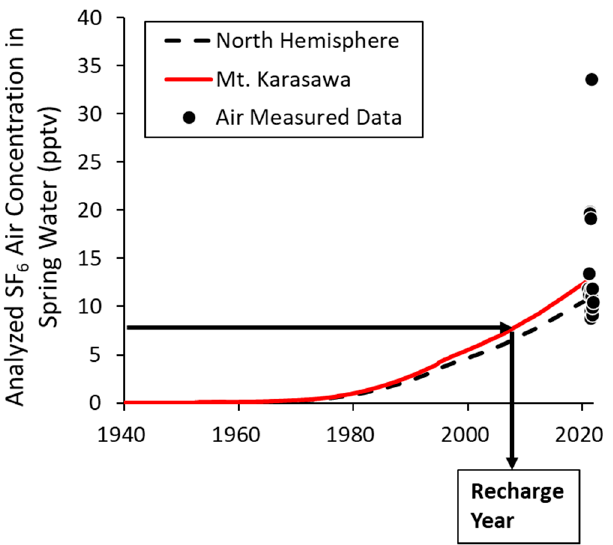
Figure 2. Air conversion lines (Mt. Karasawa area and North Hemisphere), according to the SF 6 concentrations in the air obtained in the study area, which indicate the recharge year of each water sample.